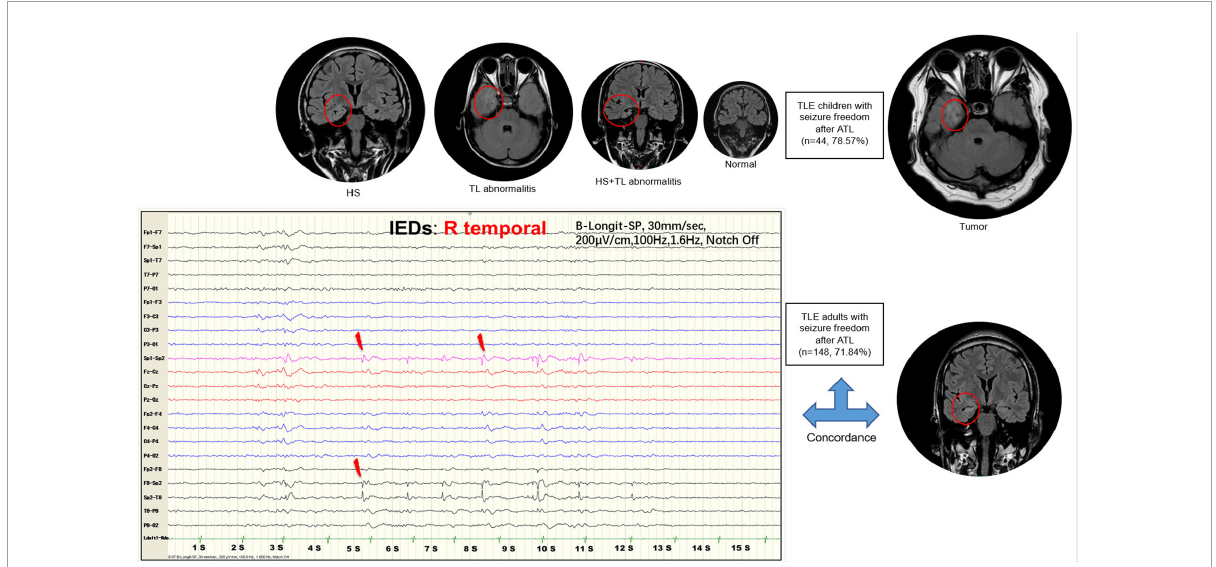
FIGURE2 The differential role of magnetic resonance imaging (MRI) in predicting surgical outcomes between temporal lobe epilepsy (TLE) children versus adults. The favorable seizure outcome of anterior temporal lobectomy (ATL) depended on the early complete resection of MRI-detected epileptogenic focus in TLE children. The size of the image represented the contribution to the favorable outcomes after surgery. The concordance of MRI with interictal epileptic discharges (IEDs) results was the only predictor of favorable seizure outcomes in TLE adults. The scalp EEG were sampled at the rate of 1,024 samples, and the typically bandpass filtered for viewing between 1.6 and 100 Hz. The data was recorded in a double banana montage, and the sensitivity was 200 µ V/cm.